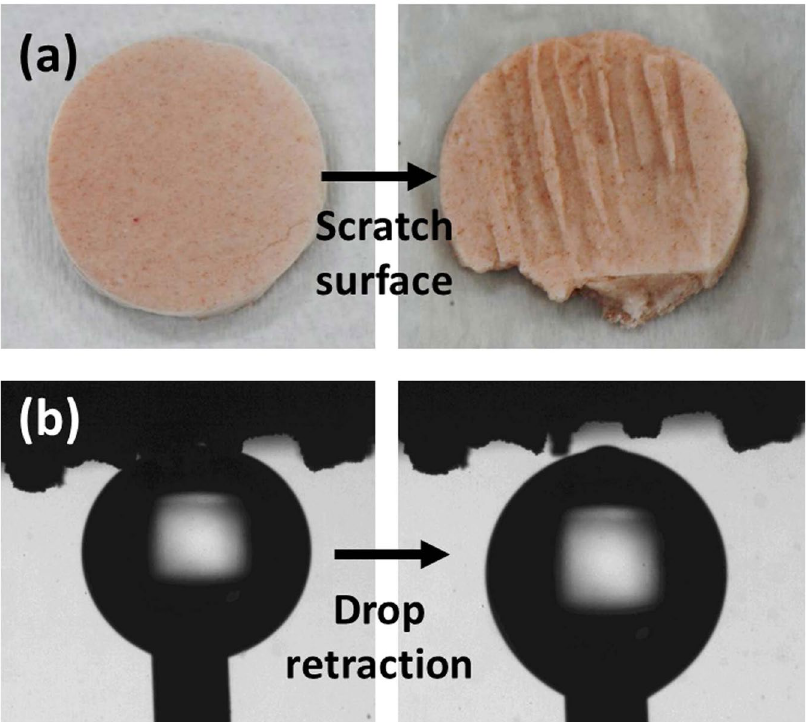
Figure 6. Evaluation of mechanical stability. ( a ) Photographs of scratched diatomite membrane. ( b ) The oil droplet profiles of the scratched membrane for demonstrating low adhesion between oil droplet and